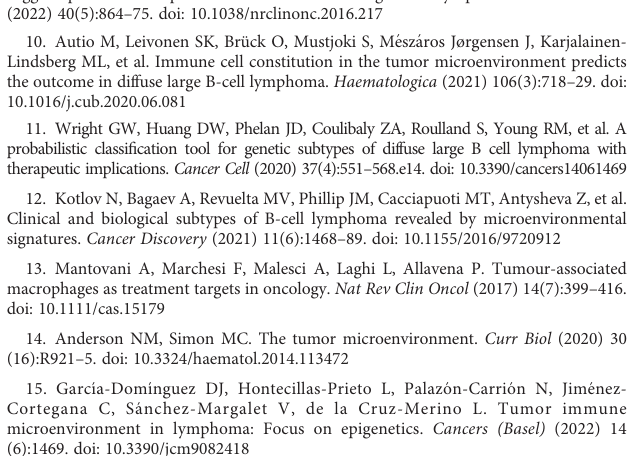
SUPPLEMENTARY FIGURE 1 Funnel plot for publication bias of total TAMs and IPI (A) , disease stage (B) , OS (C) and PFS (D) . SUPPLEMENTARY FIGURE 2 Funnel plot for publication bias of M2 TAMs and IPI (A) , disease stage (B) , OS (C) and PFS (D)